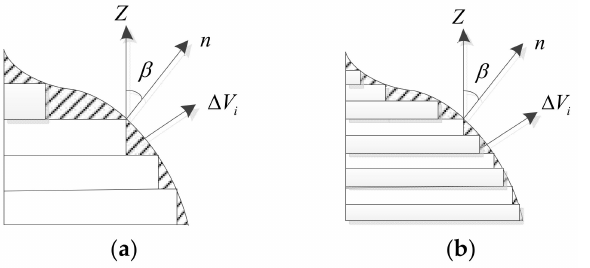
Figure 1. Step effect of FDM-3D printing. ( a ) The large volume error ∆ V i . ( b ) The small volume error ∆ V i